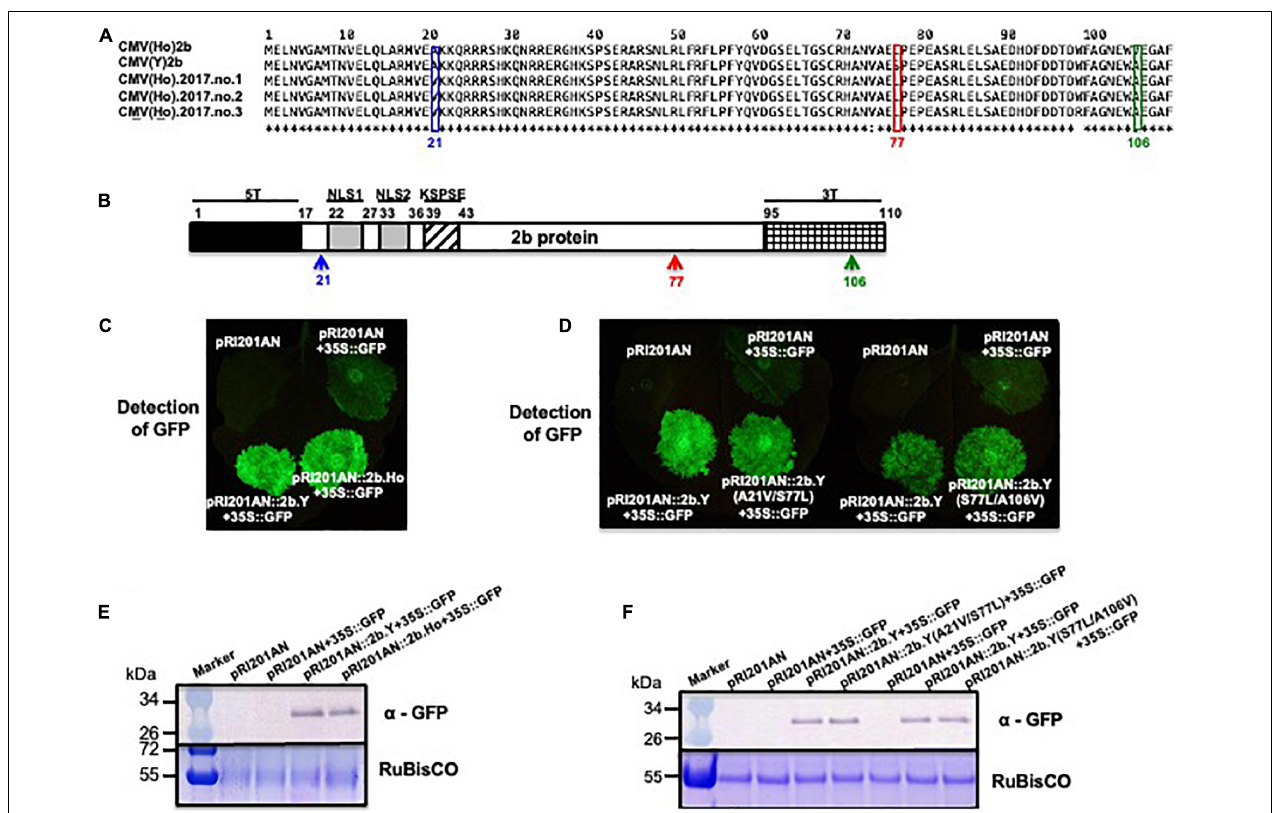
FIGURE 8 | The analysis of the RNA-silencing suppressor activity of 2b proteins of CMV(Ho) and virulent CMV(Y) and 2b proteins of CMV(Y) carrying amino acid substitutions using N. benthamiana 16c. Alignment of the amino acid sequences of 2b protein encoded by RNA2 of CMV(Ho), CMV(Ho).2017.no.1, CMV(Ho).2017.no.2, CMV(Ho).2017.no.3, and virulent CMV(Y) (A) . Single amino acid substitution at position 77 in 2b protein from serine (S) in CMV(Y) to leucine (L) in CMV(Ho), CMV(Ho).2017.no.1, CMV(Ho).2017.no.2, and CMV(Ho).2017.no.3 is indicated by a red box. Single amino acid substitutions at position 21 in 2b protein from alanine (A) in virulent CMV(Y) to valine (V) in CMV(Ho).2017.no.1, CMV(Ho).2017.no.2, and CMV(Ho).2017.no.3 and at amino acid position 106 in 2b protein from alanine (A) in virulent CMV(Y) to valine (V) in CMV(Ho) are shown by blue and green boxes, respectively. In the schematic view of 2b protein (B) , the functional domains of 2b protein for nuclear localization (NLS1 and NLS2) and phosphorylation (KSPSE), which are associated with RNA-silencing suppressor activity, are shown by gray and striped pattern boxes, respectively. T5 and 3T indicate the variable regions at the N- and C-terminals of 2b protein, respectively. pRI201AN:2b.Ho, pRI201AN:2b.Y, or pRI201AN were transiently co-expressed with 35S:GFP in the leaves of N. benthamiana 16c by the agroinfiltration method (C) . pRI201AN:2b.Y, pRI201AN:2b.Y(S77L/A106V), pRI201AN:2b.Y(A21V/S77L), pRI201AN:2b.Y, pRI201AN:2b.Ho, or pRI201AN were transiently co-expressed with 35S:GFP in the leaves of N. benthamiana 16c (D) . As a control, pRI201AN was only agroinfiltrated (C,D) . The GFP signal was visualized under a dark field (C,D) . The accumulation of GFP was detected immunologically using an antibody against GFP (E,F) . As an internal control, RuBisCO was detected by CBB staining and shown in the lower